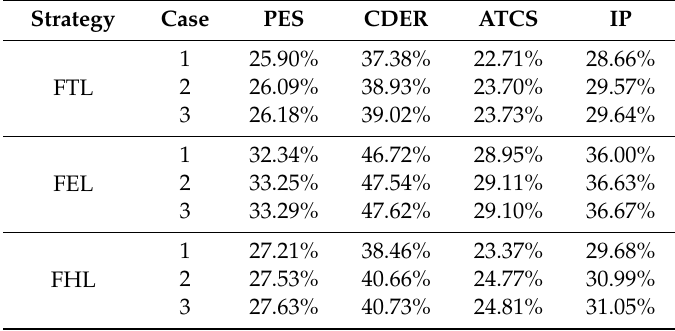
Table 3. System performances of deterministic